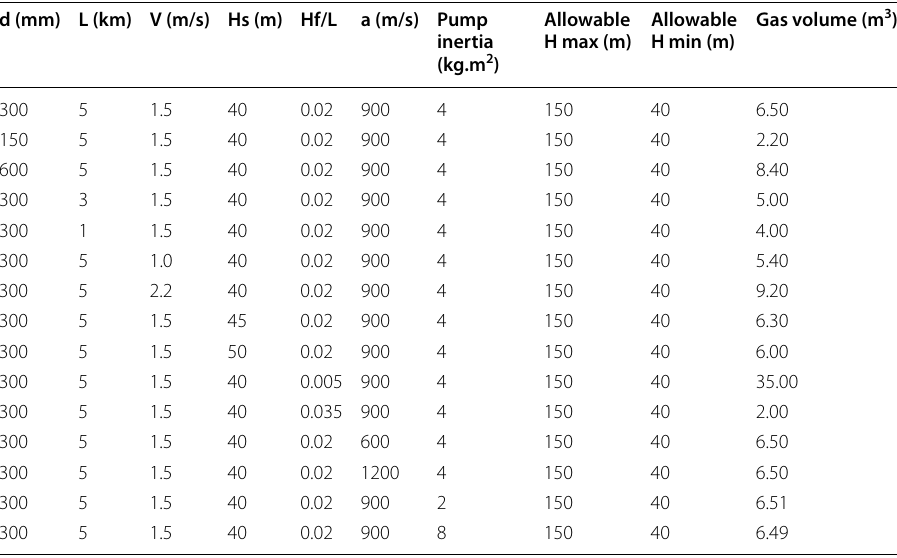
Table 2 Gas volume of air vessel for different pipe diameters (d), pipeline length (L), water velocity (V), static head (Hs), ratio between friction losses and pipeline length ( H pump